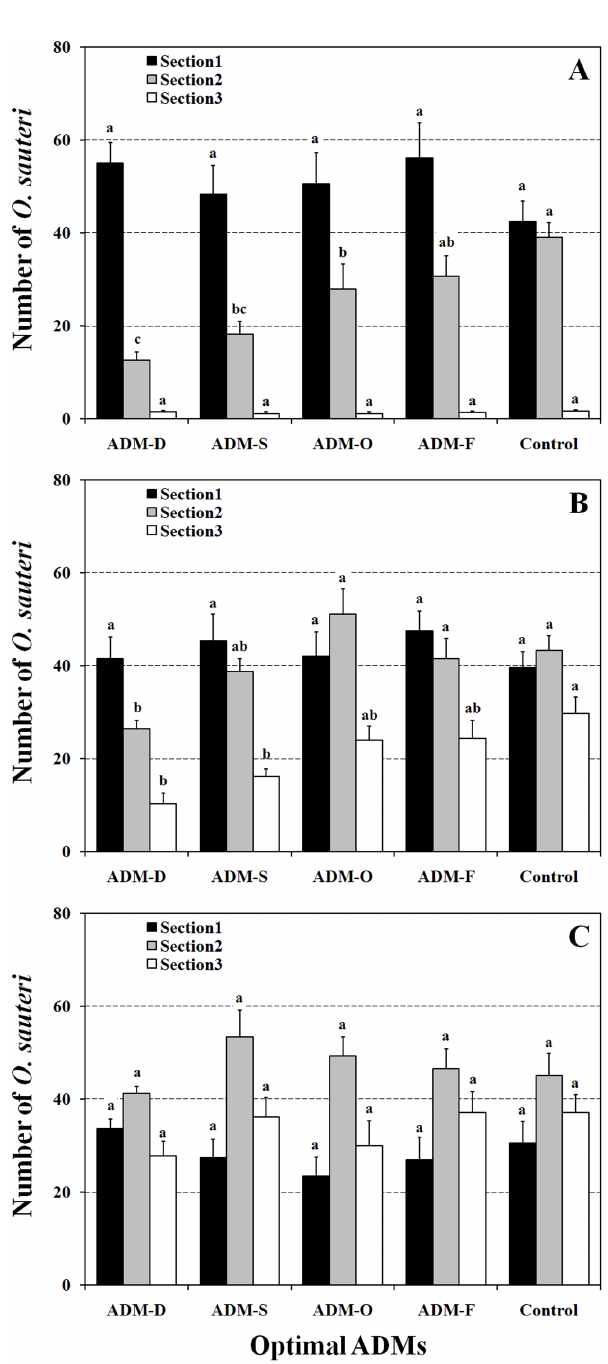
Figure 7. The numbers of O.sauteri recorded in the different sections after 24 h (A), 48 h (B) and 72 h (C). The columns and bars represent mean + SE. The different letters at the top of the columns indicate significant differences based on the LSD test (P , 0.05).